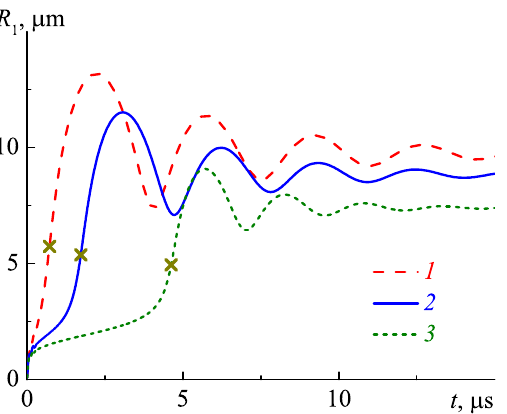
Figure 3. Vapor bubble radius at different shear moduli of the droplet shell: 1— G s = 10 7 , 2—3 × 10 7 , 3—5 × 10 7 Pa; µ l = 9 × 10 − 3 Pa · s and R 20 = 1.85 × 10 − 6 m (the cross shows the moment of complete evaporation of the droplet).